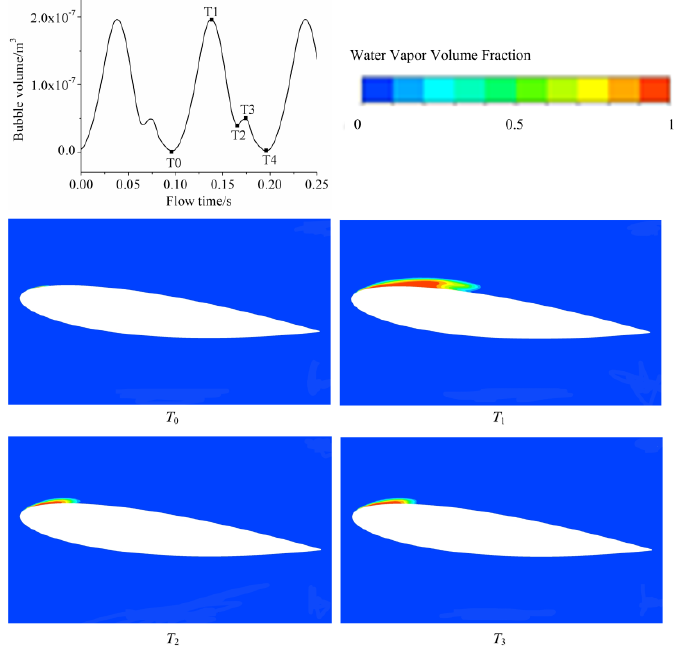
Figure 8. Bubble volume pulsation and numerical results for σ = 1.175.